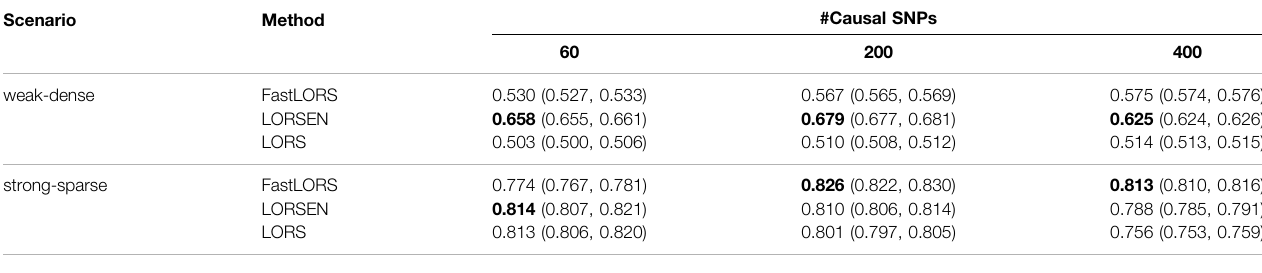
TABLE 4 | The average AUC and 95% con fi dence interval without the SNP screening with ten replicates for each simulation scenario. SNPs are from chromosome 1 and chromosome 21. For each simulation scenario, the highest AUC is in bold.